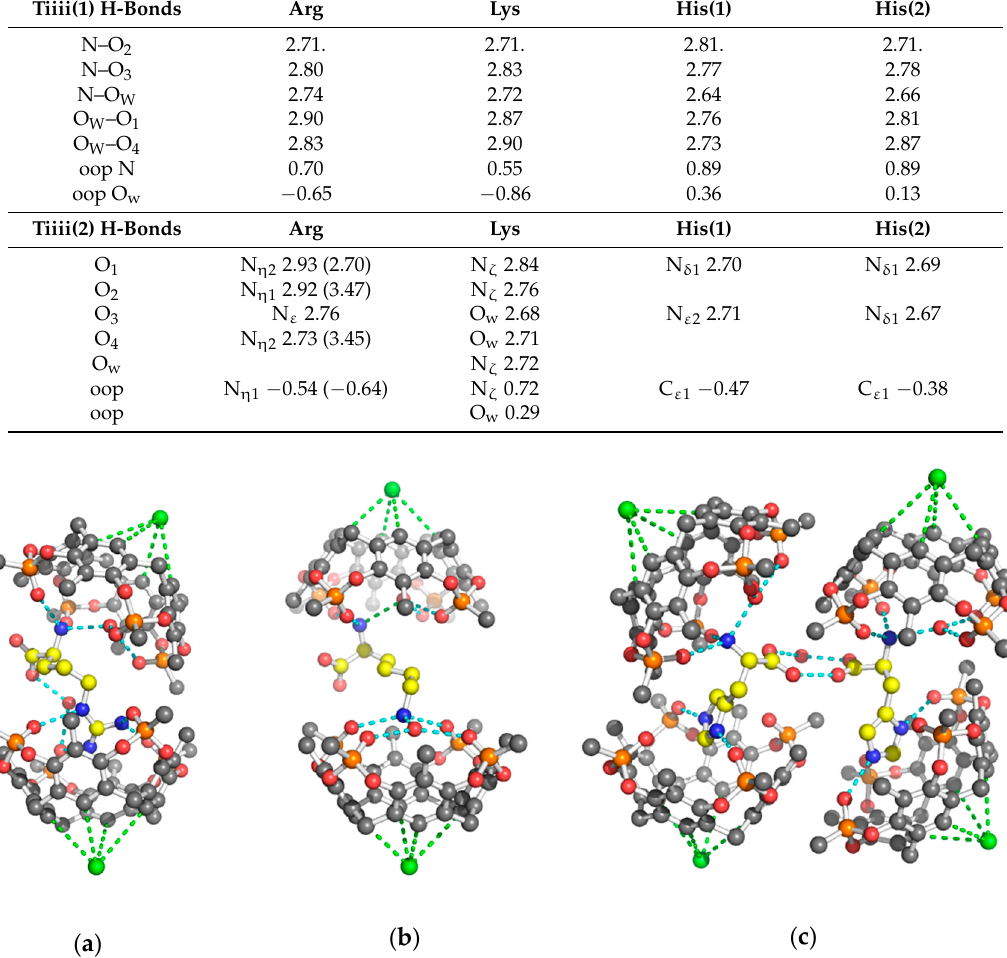
Figure 1. Ball and stick models of the crystallographic host-guest complexes. CPK colors with the